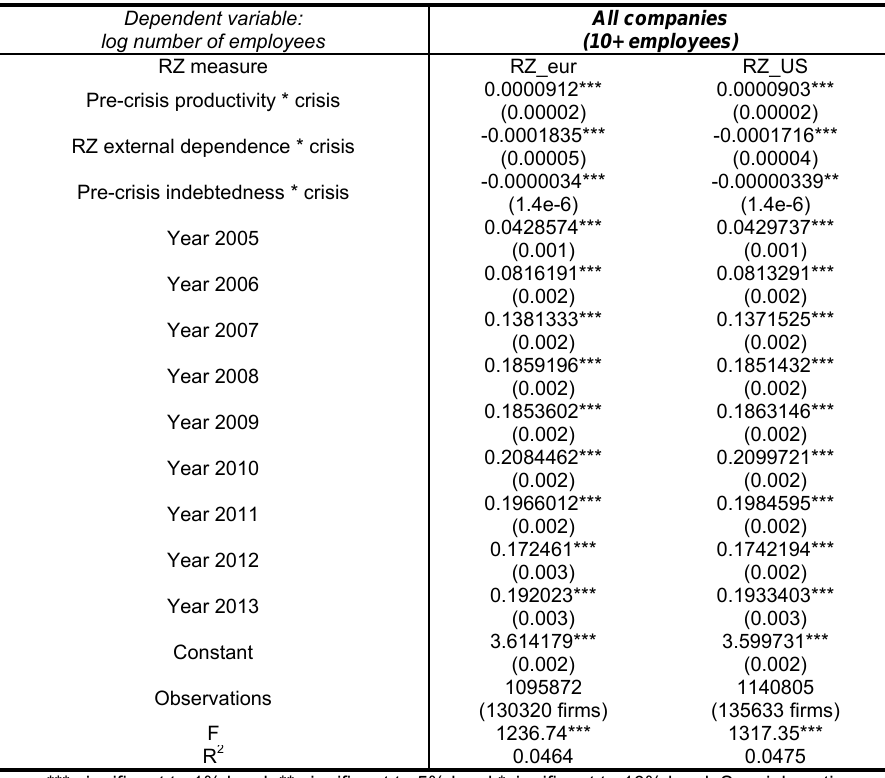
Table 4. Main regression, all